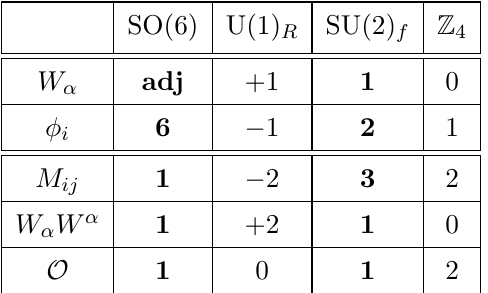
Table 10 . Quantum numbers of various fields in the SO(6) theory with two vectors φ i . The first two fields are in the UV theory, while the last three are in the IR theory. The last row is the operator